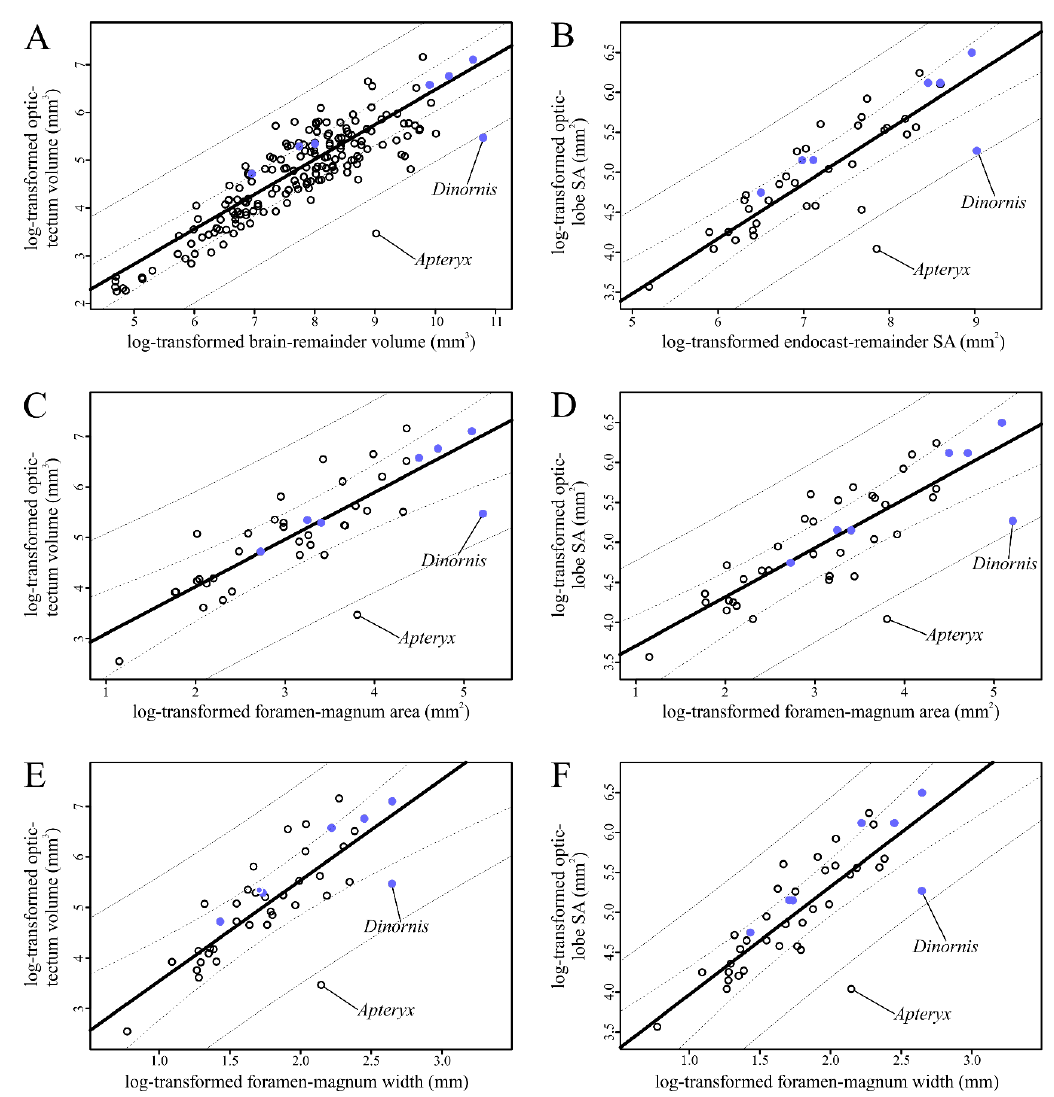
Figure 5. Scatterplots of optic-tectum metrics. All values are log-transformed, and on each plot, the solid line represents a PGLS regression from the extant sample, the dotted lines represent confidence intervals, and the dashed lines represent prediction intervals. The open points represent extant taxa. The values for the extinct sample are plotted as blue points and the points representing Dinornis and Apteryx are indicated on each plot. ( A ) Optic-tectum volume regressed on brain-remainder volume. ( B ) Optic-lobe surface area regressed on endocast-remainder surface area. ( C ) Optic-tectum volume regressed on foramen-magnum area. ( D ) Optic-lobe surface area regressed on foramen-magnum area. ( E ) Optic-tectum volume regressed on foramen-magnum width. ( F ) Optic-lobe surface area regressed on foramen-magnum